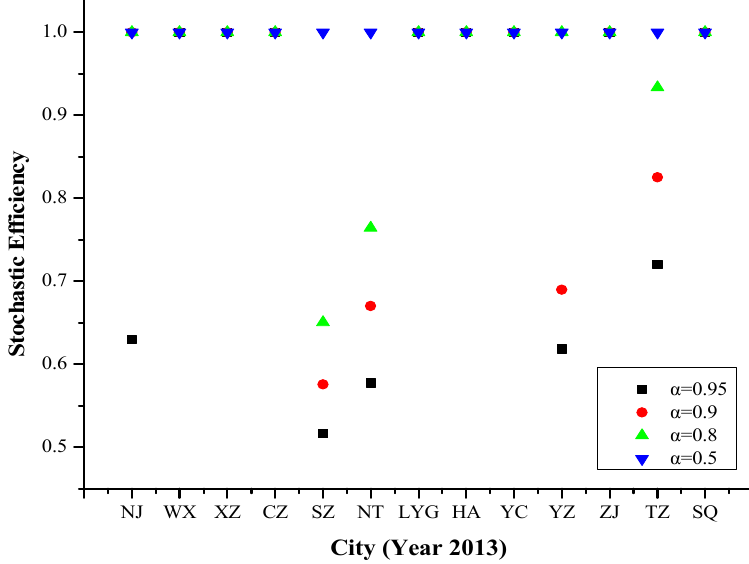
Figure 2. Stochastic efficiency values of 13 cities in Jiangsu Province at different risk levels in 2013.